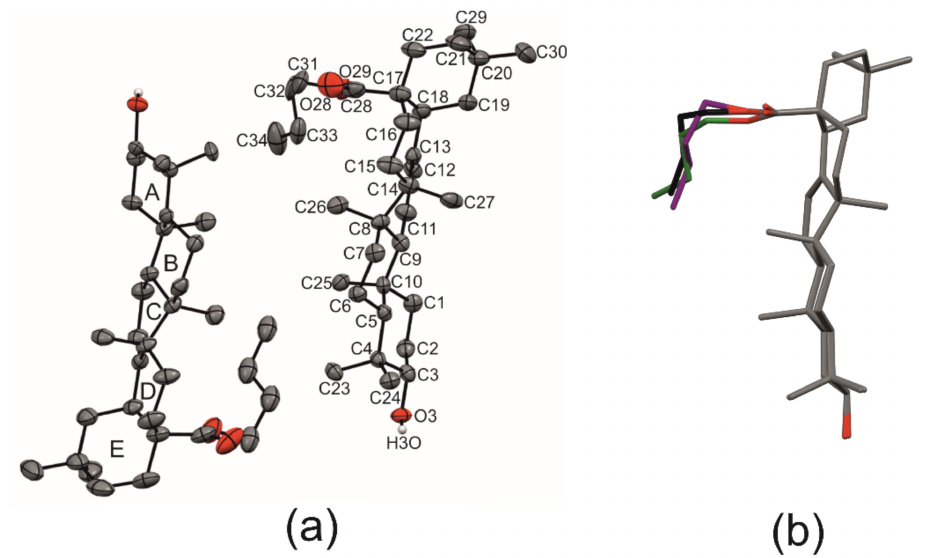
Figure 3. ( a ) ORTEP representation of an asymmetric unit of R 3-but-OA : For molecule A, atoms are labeled; the numeric scheme for molecule B is the same. For molecule B, only the major position of the disordered butyl substituent is shown. Except for these from the O-H group, the H atoms are omitted for clarity. Displacement ellipsoids are at a 50% probability level. ( b ) Superposition of two symmetry-independent ester molecules in R 3-but-OA . The butyl substituent of molecule A is colored green, violet major (66.2%), and black minor (33.8%) positions of molecule